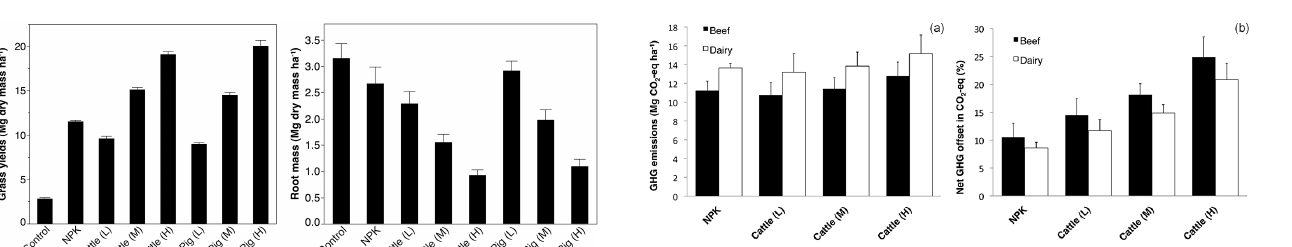
Figure 5. Relationships between (a) grass yields (averaged for five recent years 2009–2013) and (b) total root mass (measured in 2014 between 0 and 20cm soil depth) and the different nutrient treat- ments. Abbreviations as in Fig. 1. Standard errors indicate variation among six replicate values for each treatment.